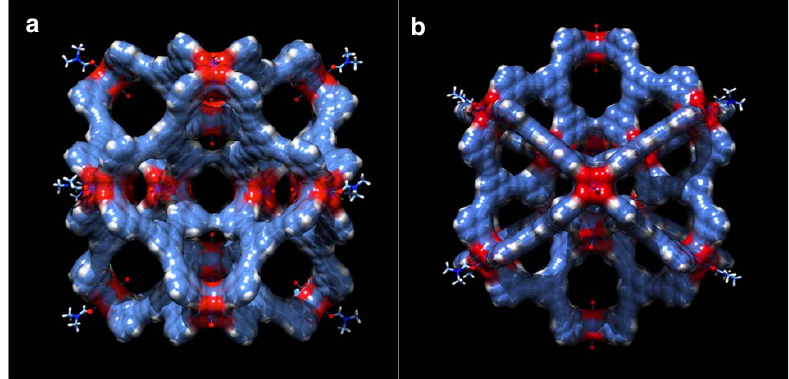
Figure 4 | Space-filling representations of SK-1A. The molecular structure is shown from two different perspectives ( a , b ); Colour code, blue C, red O-donor coordination in the {Cu 2 } units, white H, dark blue N; coordinating solvent molecules are shown in non space-filling